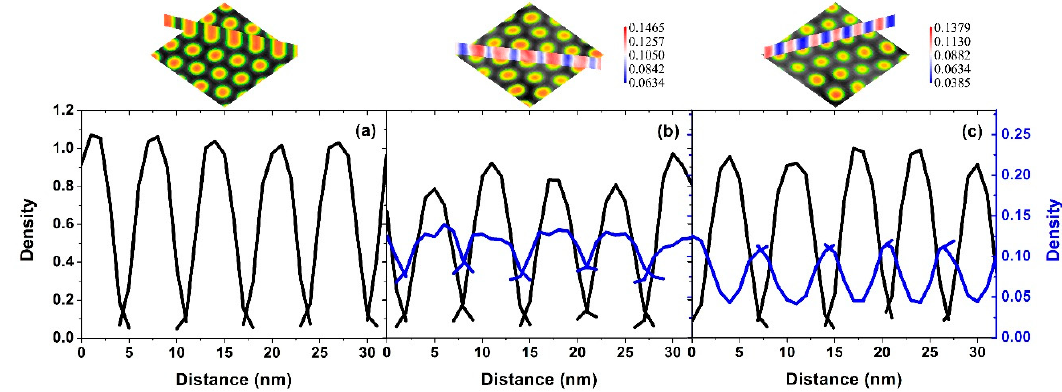
Figure 2. Density distributions of B beads (denoted by black line) and solvent beads (denoted by blue line) from the radial direction of a self-assembled cylinder array in ( a ) plain copolymer; ( b ) copolymer doped with 10% hydrophobic solvent; and ( c ) copolymer doped with 10% hydrophilic solvent systems. Three density-slice pictures are placed above each subfigure, respectively. In each density-slice picture, one density slice lays along the X–Y plane, and the other density slice goes through the cylindrical axes in the same cylindrical array, where the latter is vertical to the former. The color mappings of A, B and solvent beads are in white-black, reverse rainbow and blue-white-red, respectively.